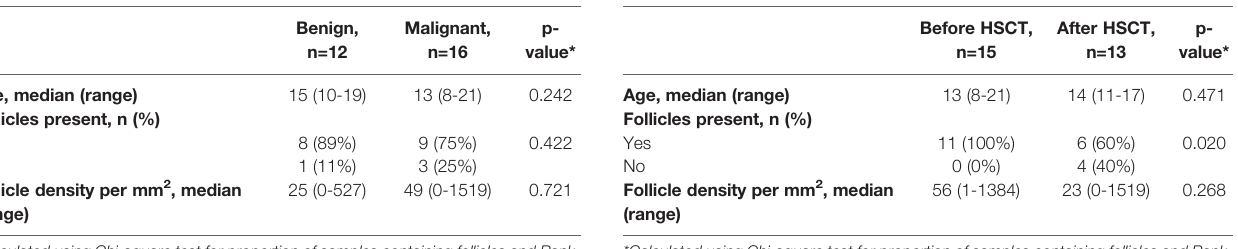
TABLE 3 | Ovarian tissue cryopreservation before and after